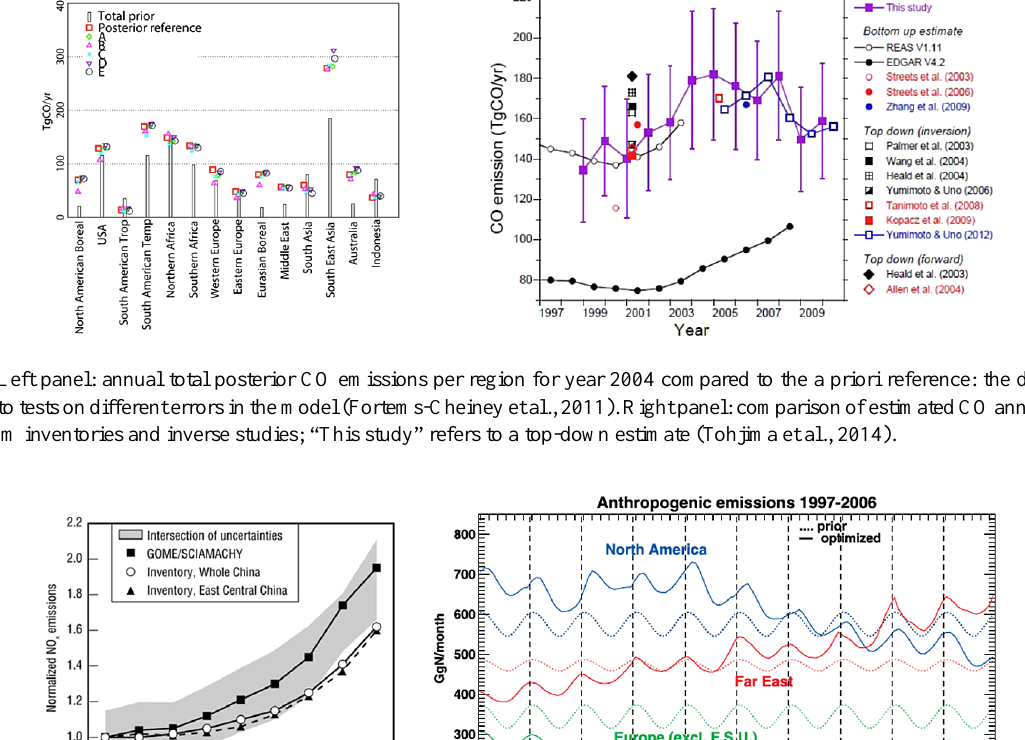
ozone retrievals from satellite data (Liu et al., 2006). The AMMA campaign (Redelsperger et al., 2006) and associated analysis performed with the in situ MOZAIC (Sauvage et al., 2005) and SHADOZ data (Thompson et al., 2003a,